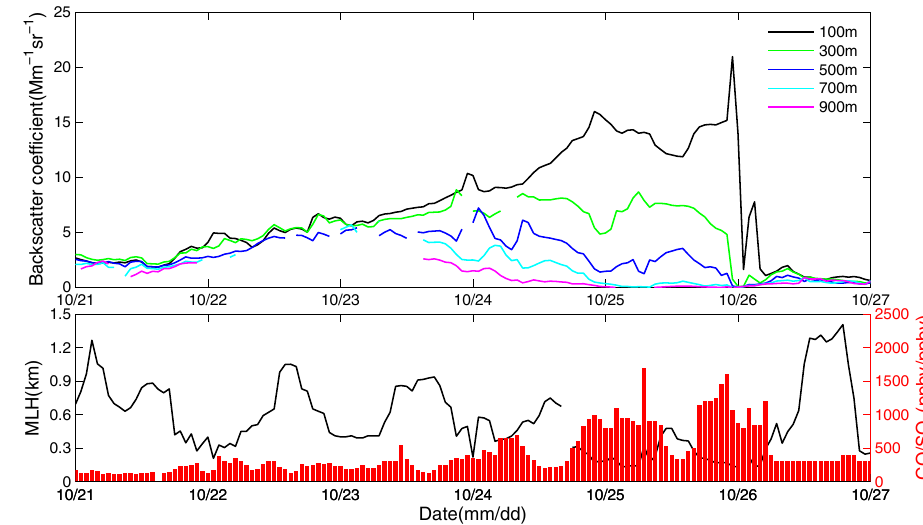
Figure 9. Attenuated backscattering coefficients at different heights and near-surface CO / SO 2 ratios from 21 to 26 October.